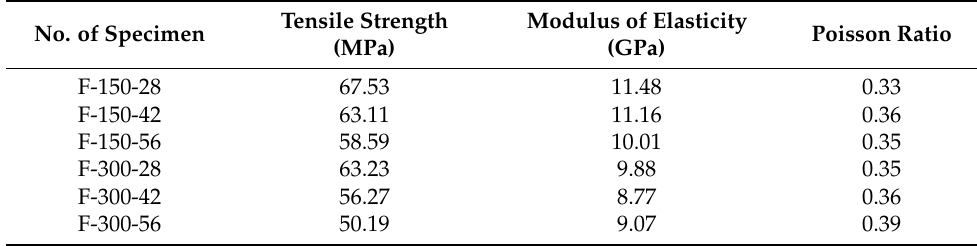
Table 3. Test results of FFRP tensile test